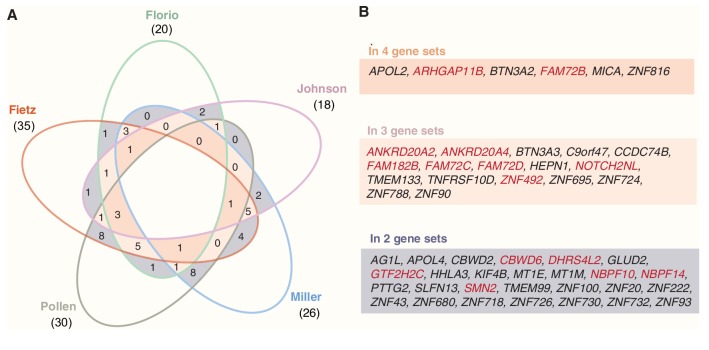
Occurrence of the 50 primate-specific genes in the five gene sets.(A) Venn diagram showing the numbers of the 50 primate-specific genes that are found in each of the five gene sets, and the numbers found in two (violet), three (pink), or four (orange) gene sets. (B) Specification of the primate-specific genes that are found in two (violet), three (pink), or four (orange) gene sets. Genes depicted in red are human-specific.